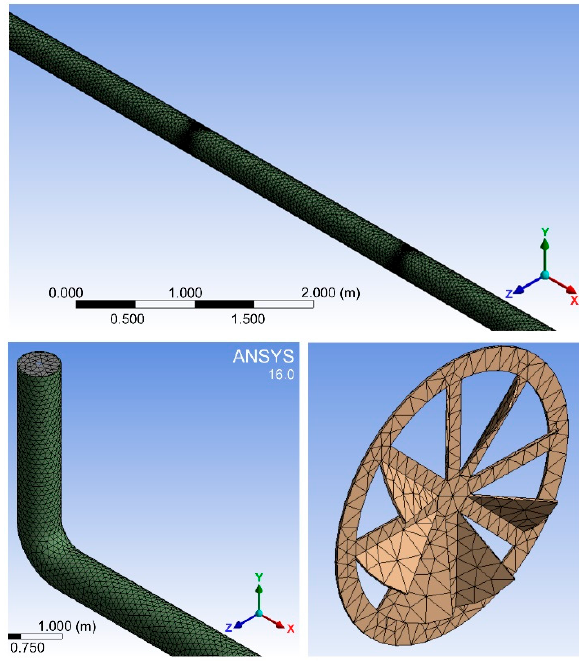
Figure 4. Mesh generation.